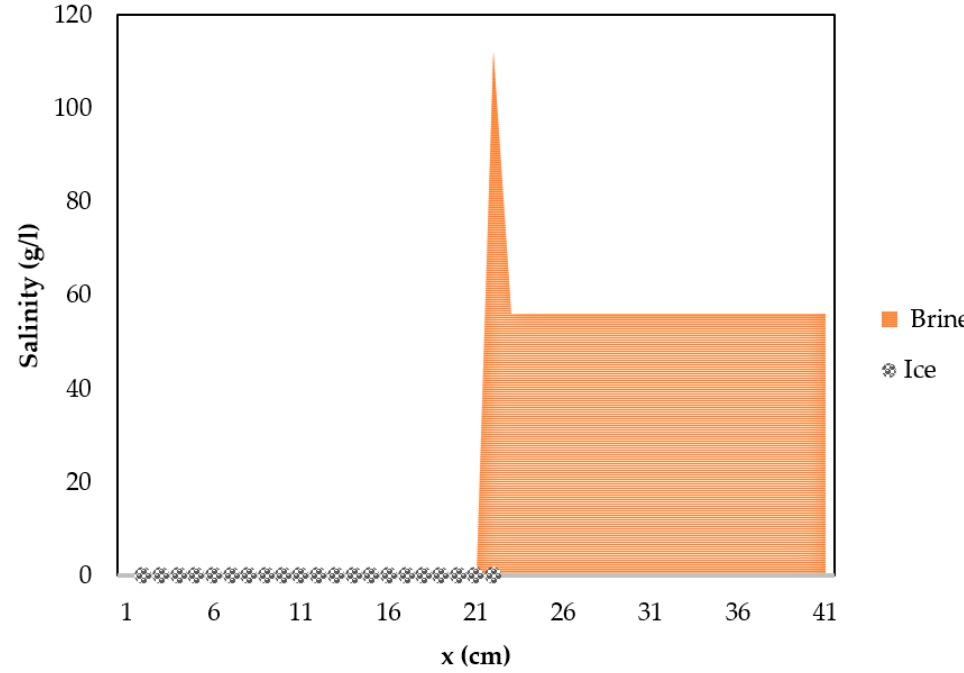
Figure 7. Salinity profile for 40 cm length process, with an interface at 21 cm.